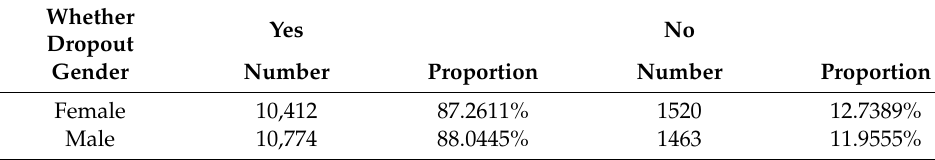
Table 4. Number and proportion of dropouts by